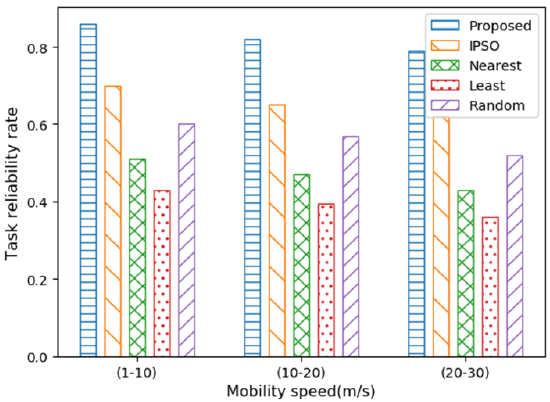
Figure 8. Task reliability rates for mobility speed.